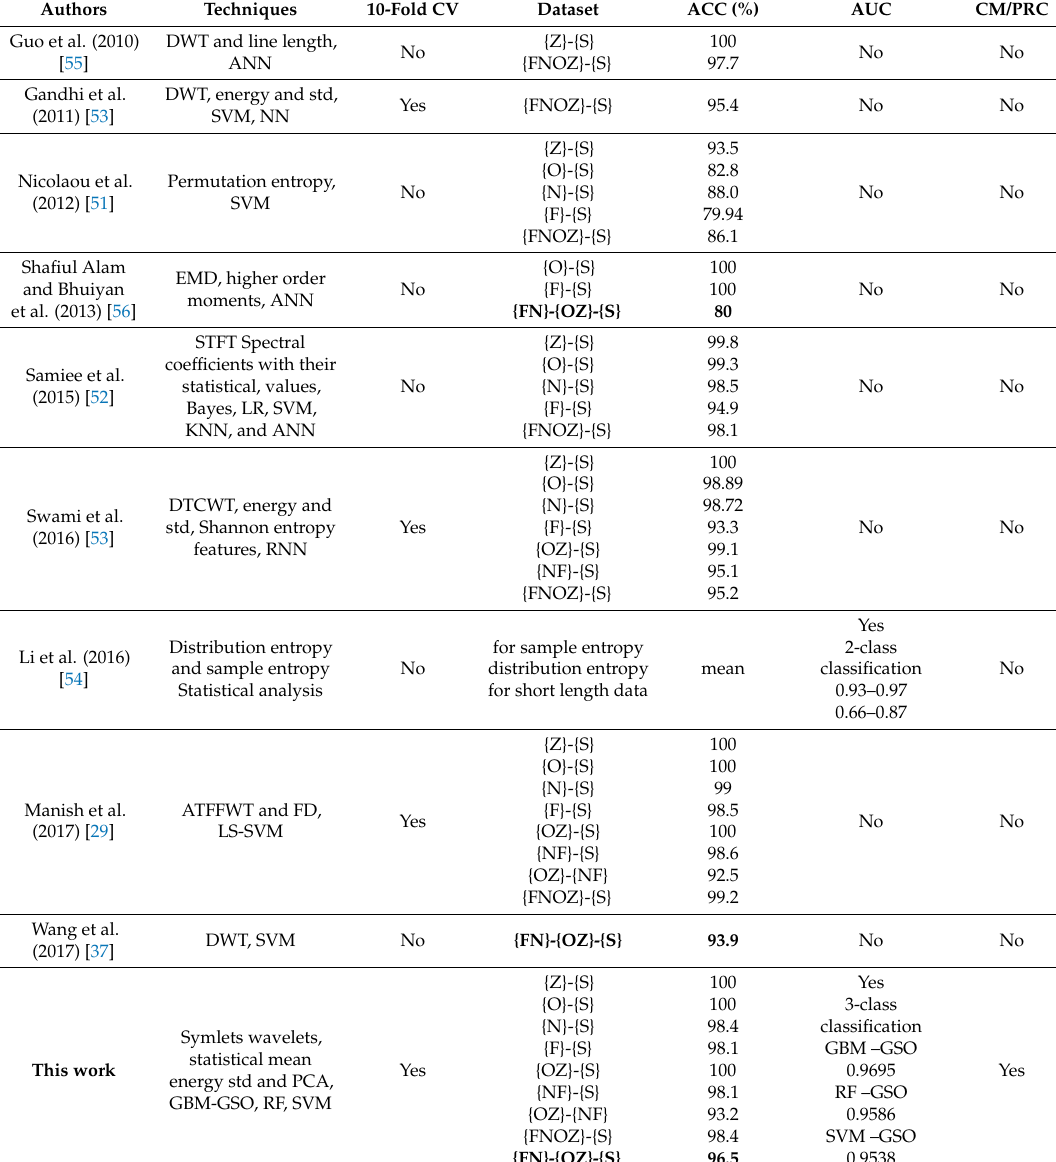
Table 5. Comparison of results of the proposed method with those of existing methods for accuracy, area under the curve, receiver operating characteristic, confusion matric and precision–recall curve of for the two- and three-level-class classifications on the Bonn University